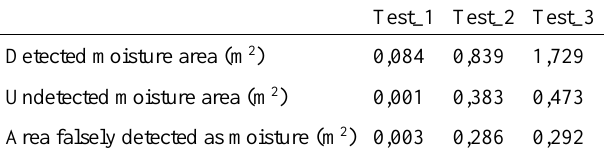
Table 3. Detected/undetected moisture area, and area